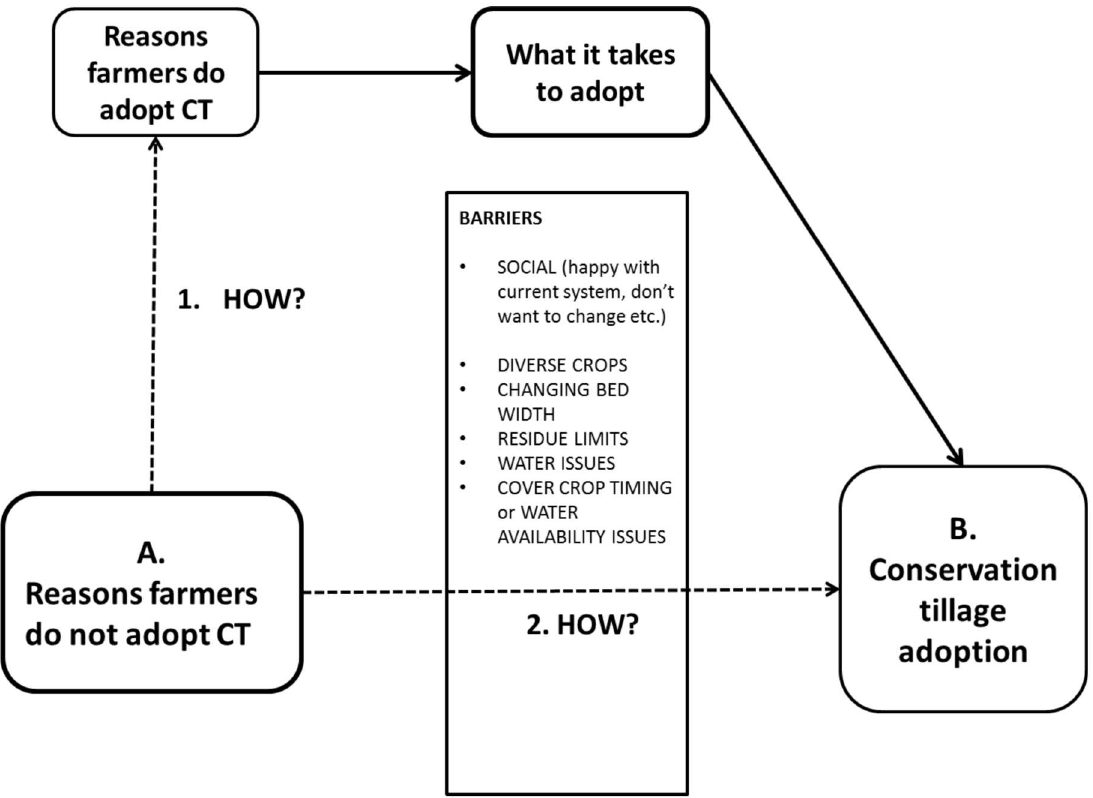
Fig 6. Flow chart of the two paths to CT adoption. (1) The path of farmers who have already successfully adoptedCT. (2) The path of farmers that must addressbarriers particular to their farm or issues that have not yet been overcome by other